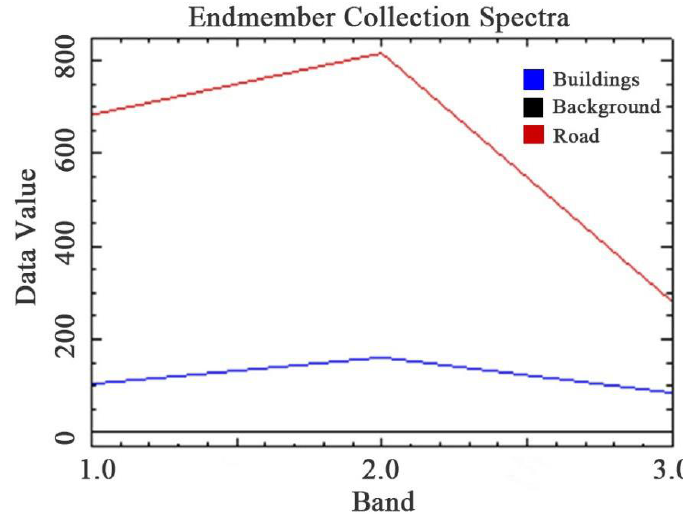
Figure 3. Spectral characteristic curves of ground surface objects.